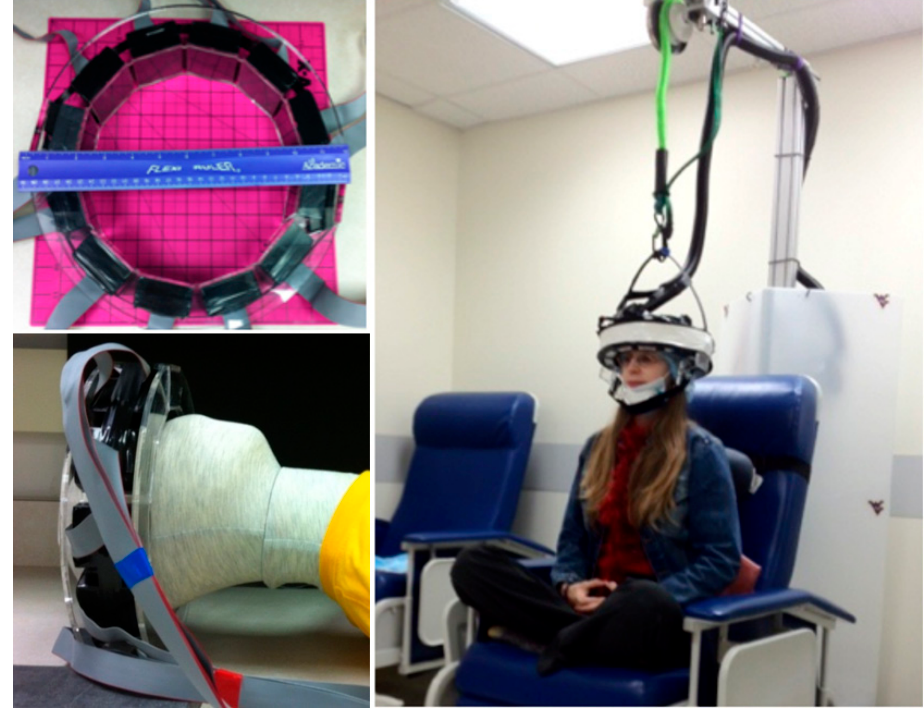
Figure 1. Original Helmet_PET module setup, left; AM-PET Helmet_PET in action showing green bungee cord going over pulley and support frame, right.